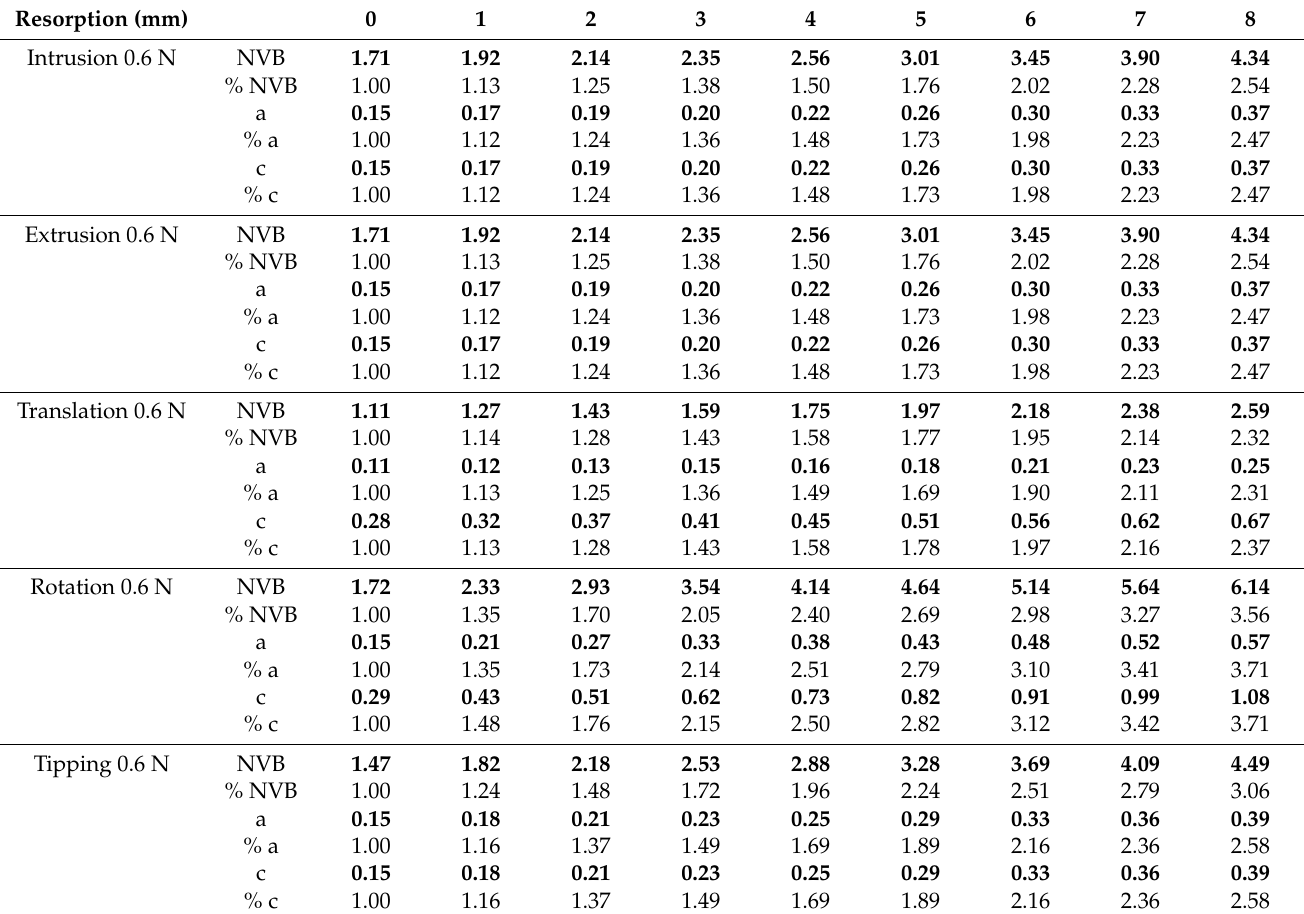
Table 2. The Tresca shear-stress average values (KPa) produced by 0.6 N of orthodontic forces.